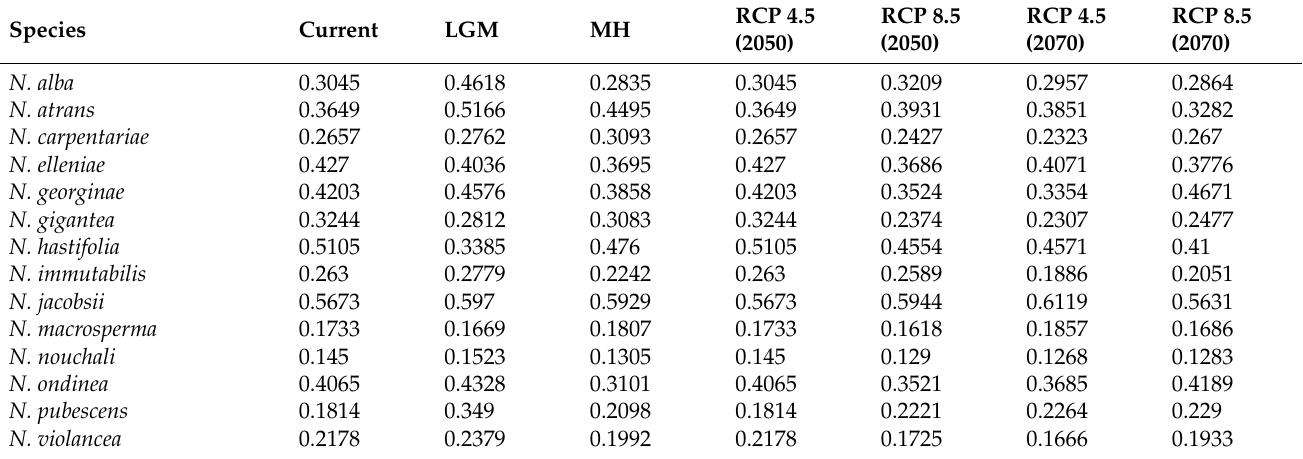
Table 4. Maximum training sensitivity plus specificity (MTSS) Values used in classifying MaxEnt output raster files into suitable and unsuitable